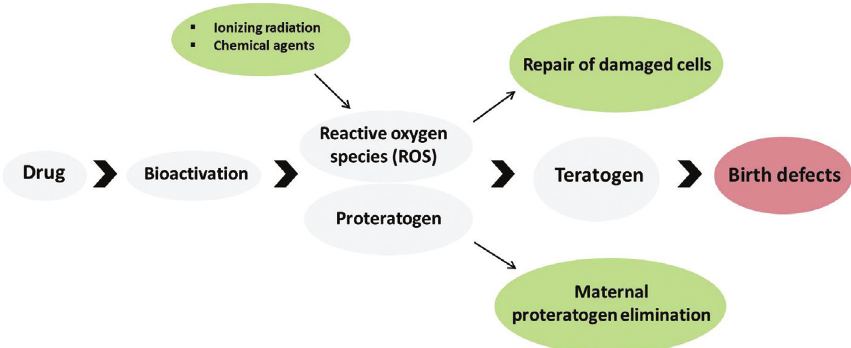
Figure 1 - Teratogenesis pathways due to oxidative